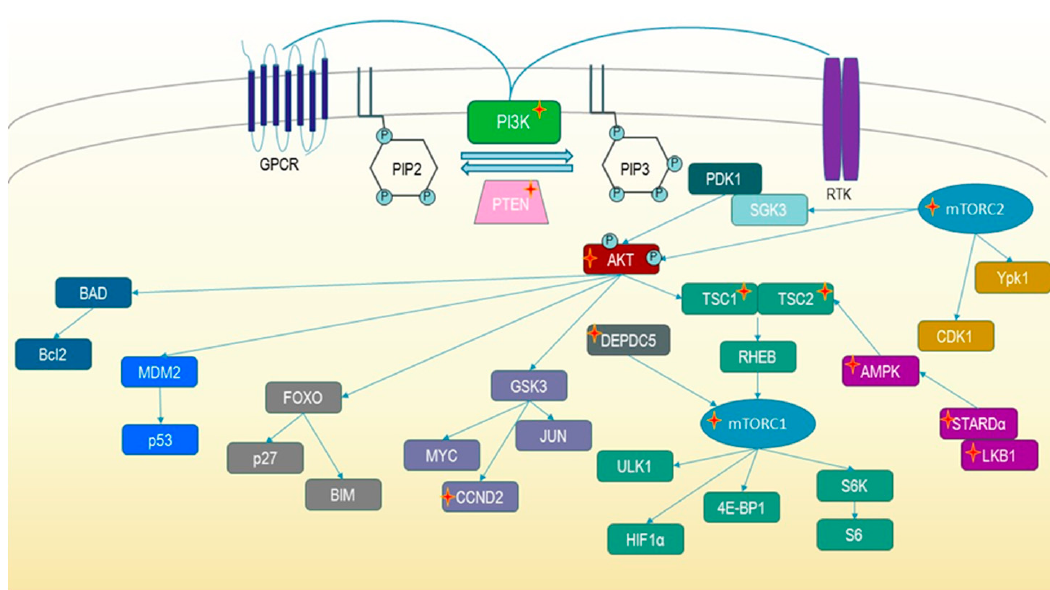
Figure 1. PI3K/mTOR signaling cascade. Arrows address downstream signaling, which leads to inhibition or activation of pathway components resulting in growth, survival, and proliferation. Pathway hyperactivation can be induced by mutations of different genes (marked with a red star) leading to genetic overgrowth syndromes or mTORopathies.